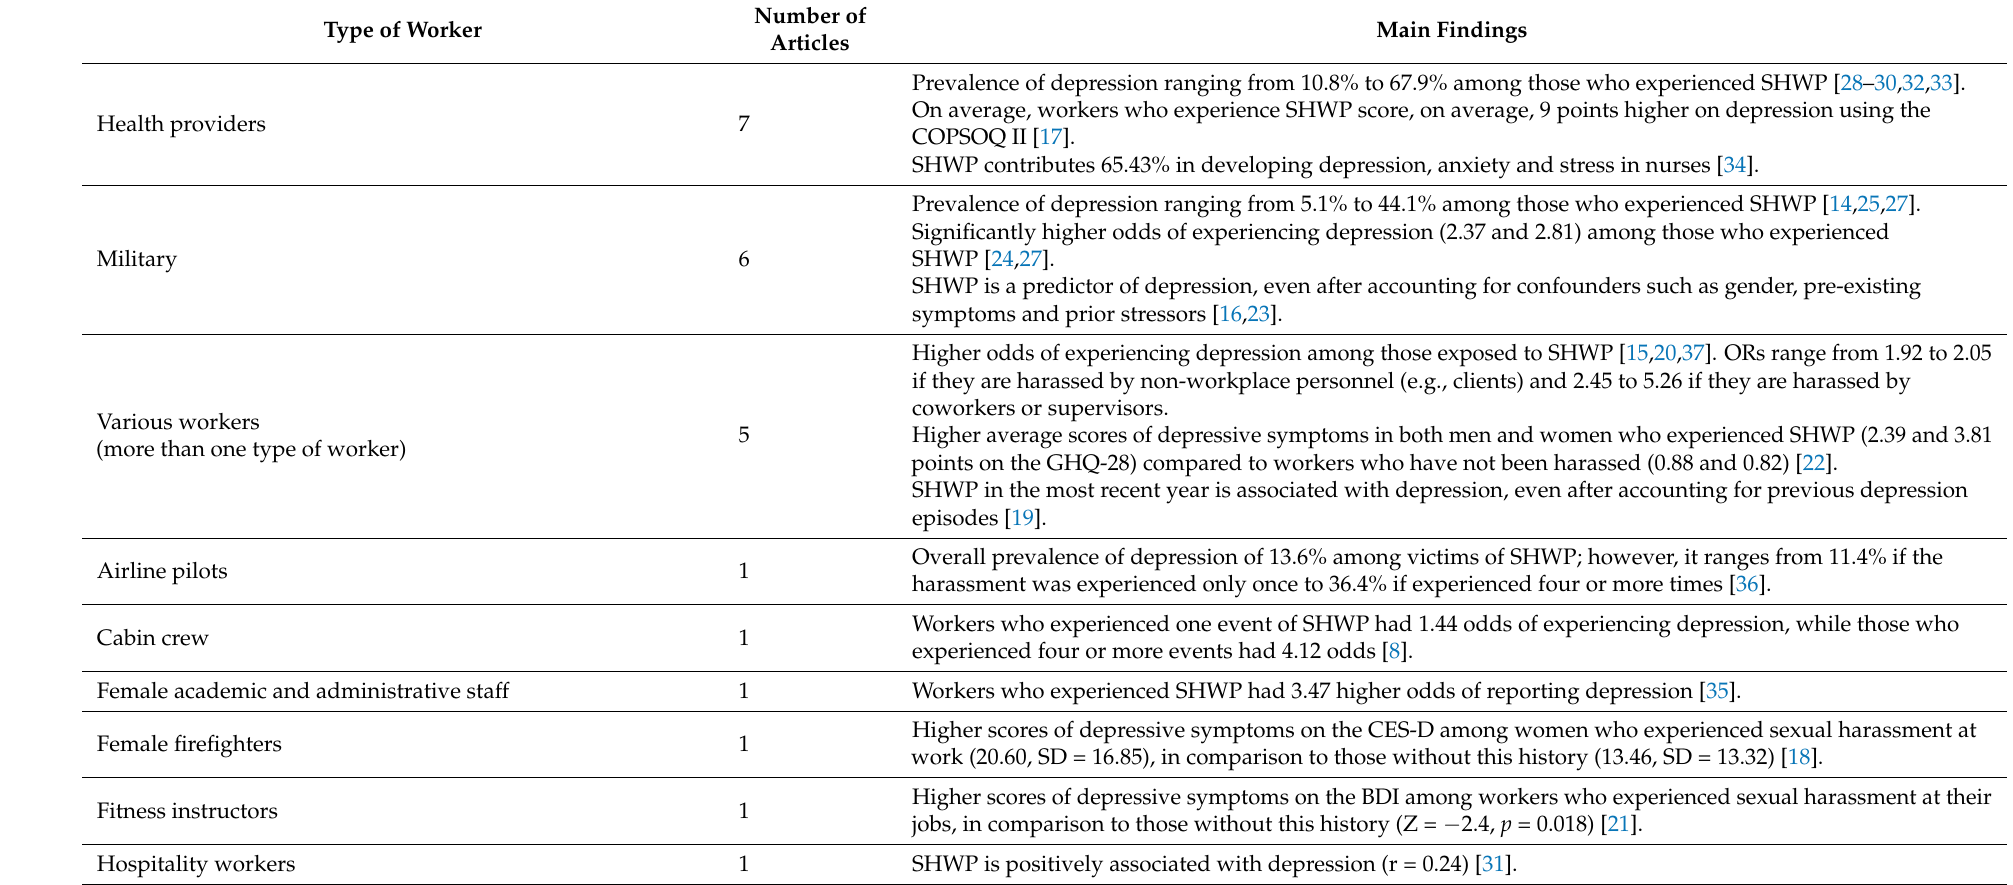
Table 1. Narrative summary of the association between depression and